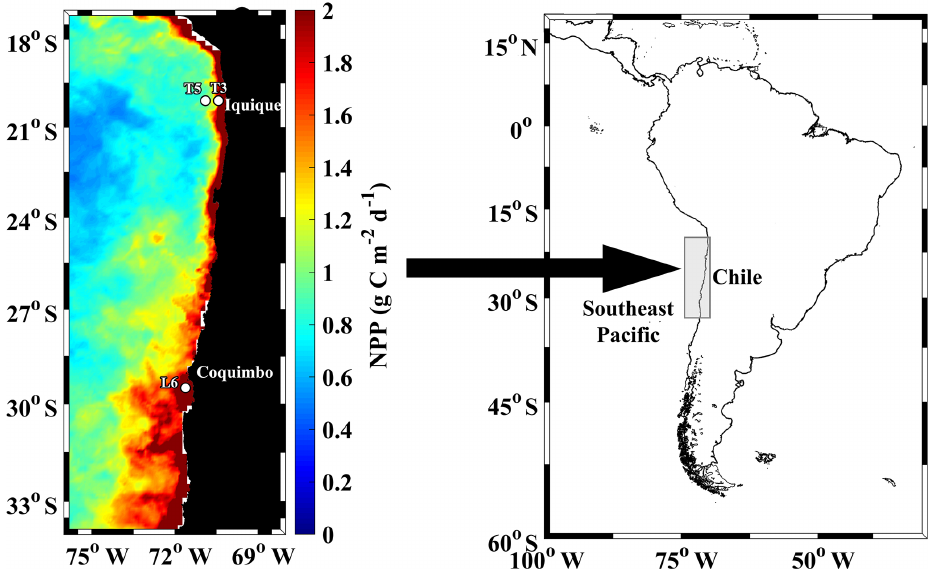
Figure 1. Study area at the northern upwelling region of Chile, indicating sampling stations during the Lowphox cruise conducted in November–December 2015 onboard the R/V Cabo de Hornos . Satellite estimated net primary production (NPP), averaged for November– December 2015 is shown. NPP was obtained from http://www.science.oregonstate.edu/ocean.productivity/, last access: 17 December